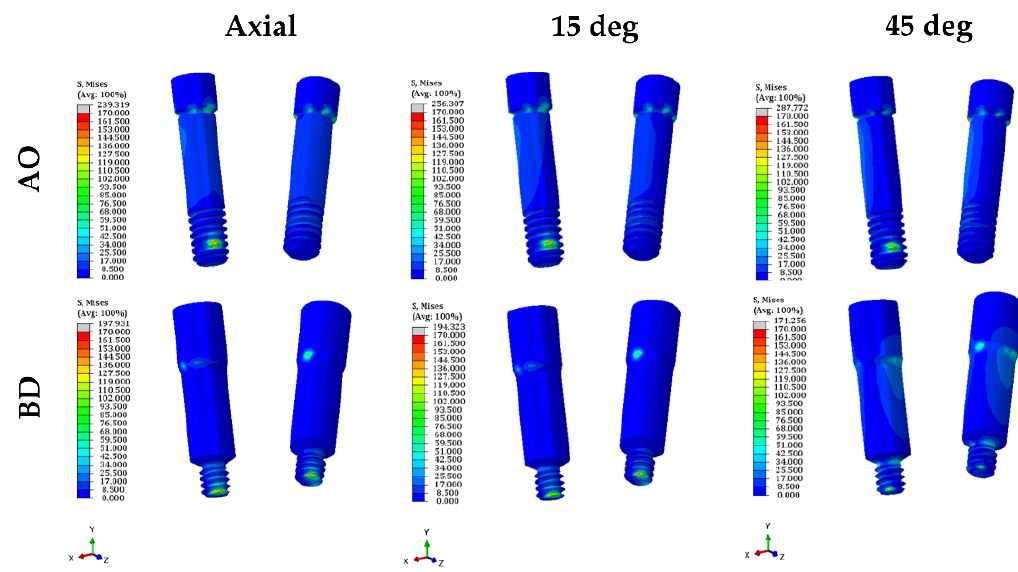
Figure 7. Stress distribution diagram of abutment screw in both models.